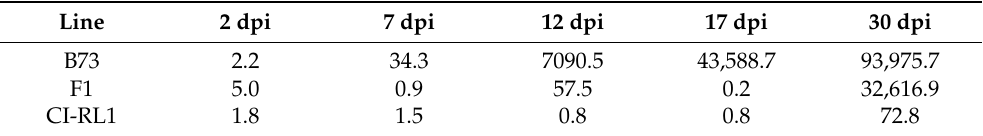
Table 1. Relative expression levels of SCMV Coat Protein (SCMV-CP) in the three different lines at 2, 7, 12, 17, and 30 dpi measured via qRT-PCR.